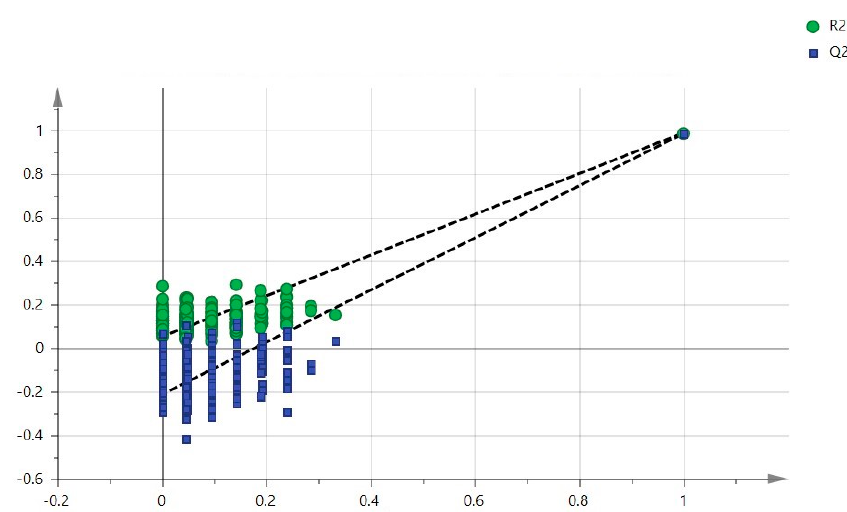
Figure 2. Contribution plot from the model including total VIP; peaks with positive contribution scores correspond to metabolites with higher levels. The Y-axis indicates the VIP scores correspond- ing to each variable on the X-axis.